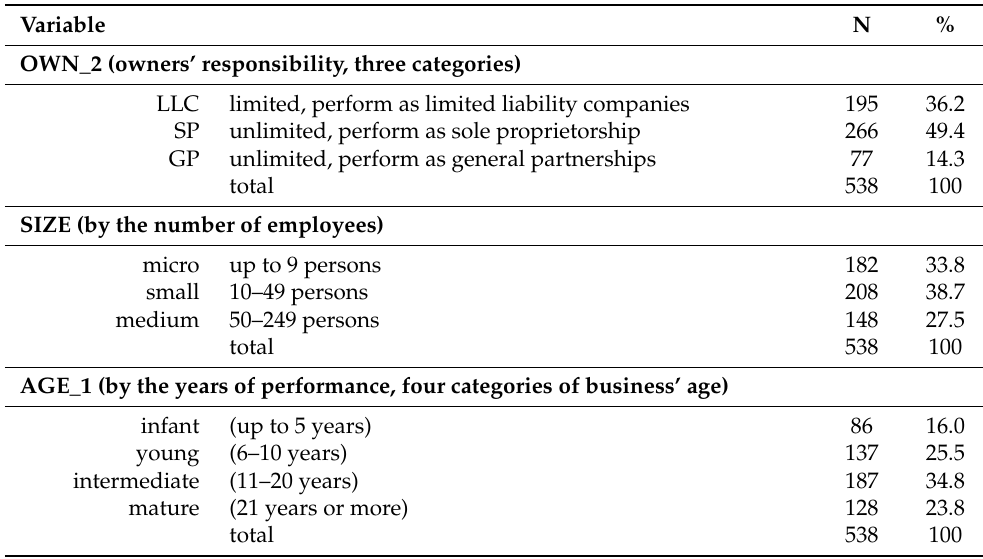
Table 2. Sample composition and variables that explain the businesses characteristics relevant for this